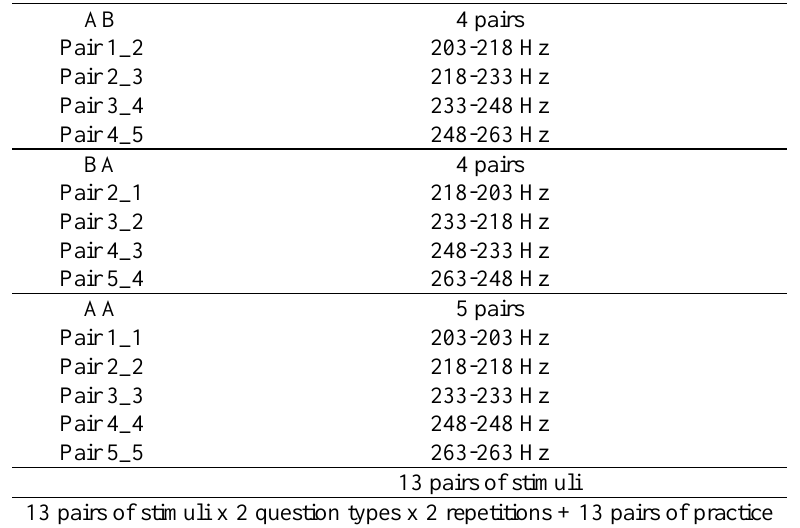
Table II. Pairs of stimuli for the discrimination